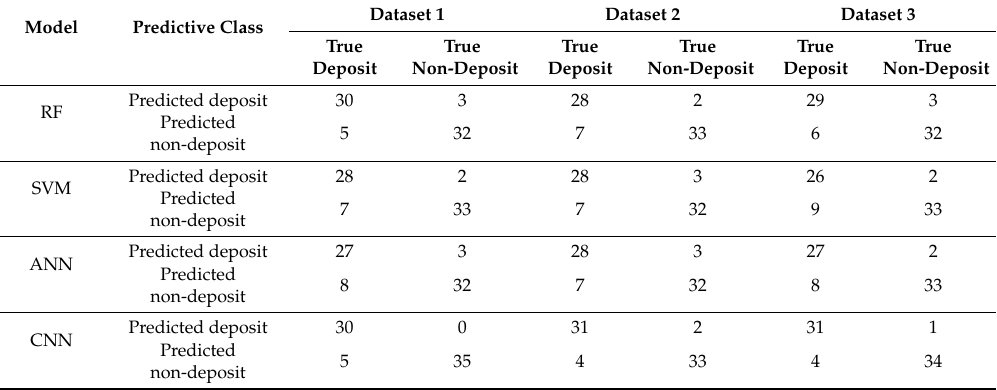
Figure 10. Predictive maps showing average probability output by machine learning models based on three input datasets: ( a ) RF; ( b ) SVM; ( c ) ANN; and ( d ) CNN models. Table 2. Confusion matrices of machine learning models in di ff erent validation